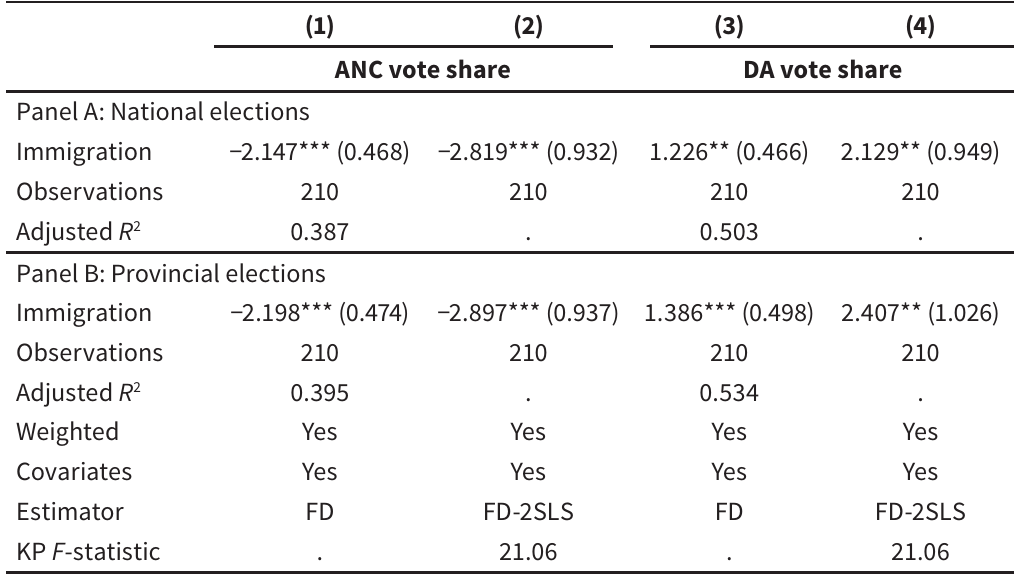
Notes : Robust standard errors clustered at the district level in parentheses. Census data for 2001 and 2011 (IPUMS International). National and provincial election results from 2004 and 2014 (Electoral Commission). First differenced regressions. Covariates defined at the municipality level and as a share of the relevant native population include urban population, female popula- tion, unemployment rate, internal migration, ethnic diversity measured as the Herfindahl index based on languages spoken, access to electricity, and adult illiteracy (no schooling). District-level covariates defined in 1991 include the agriculture and mining sectors employment shares. Immi- gration is instrumented with a shift-share Bartik instrument using 1991 census data.